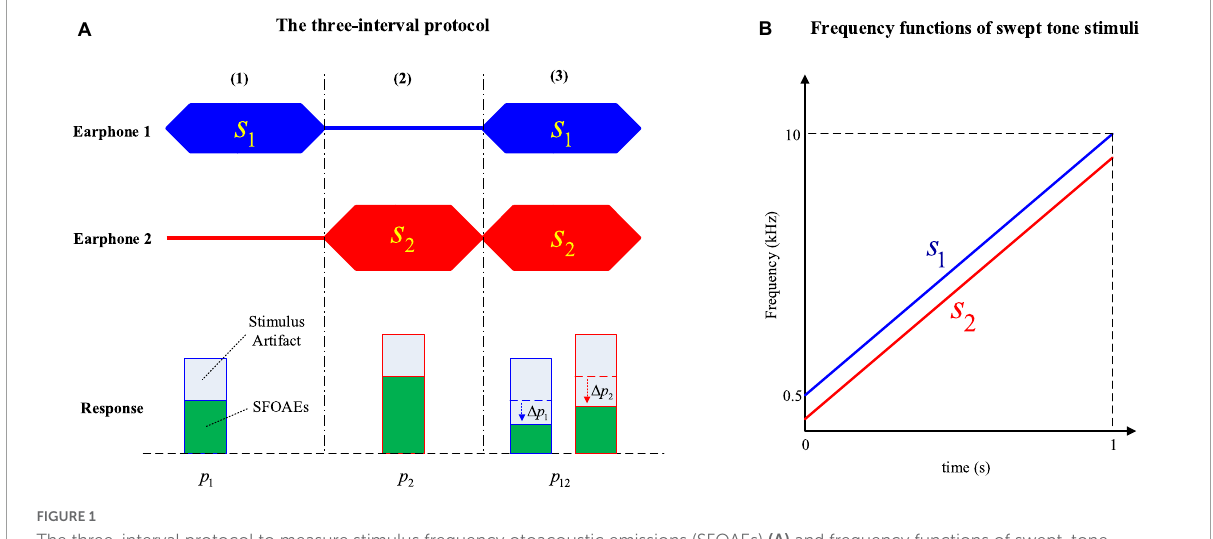
FIGURE1 The three-interval protocol to measure stimulus frequency otoacoustic emissions (SFOAEs) (A) and frequency functions of swept-tone stimuli (B)